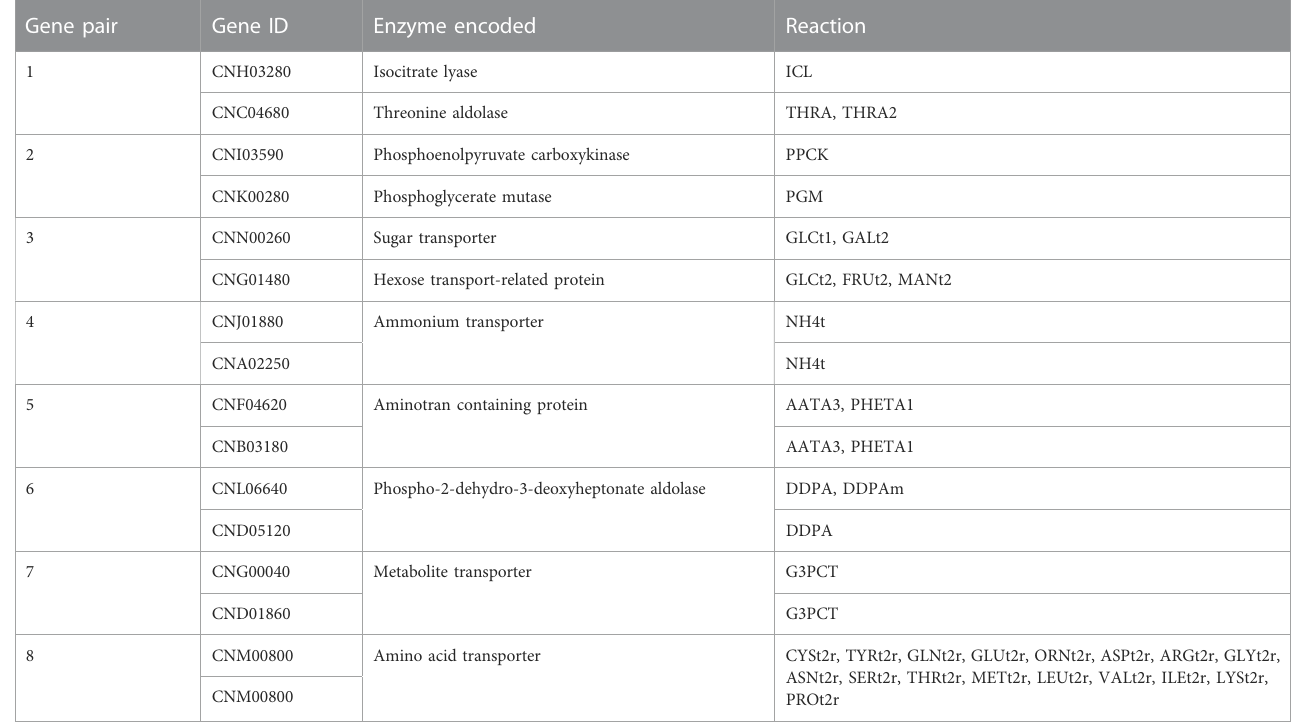
TABLE 3 Essential gene pairs and reactions as a result of double gene deletion analysis. Gene